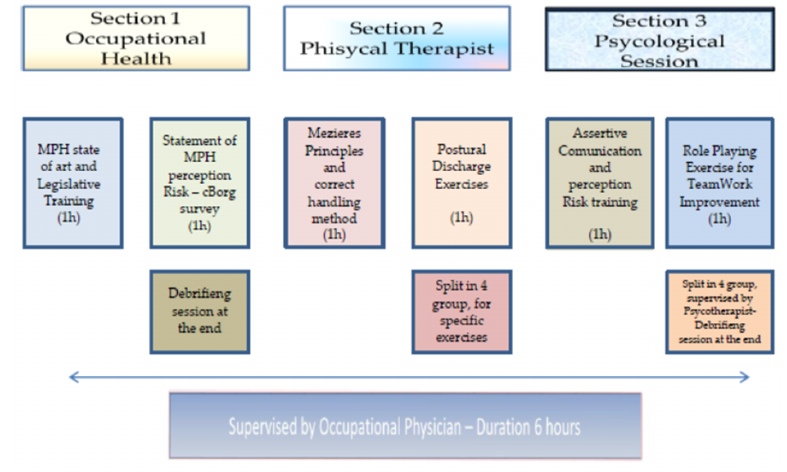
Figure 2. Training program scheme.